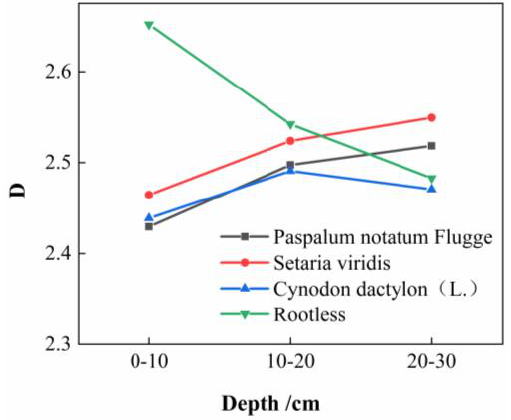
Figure 13. The effect of depth on D.